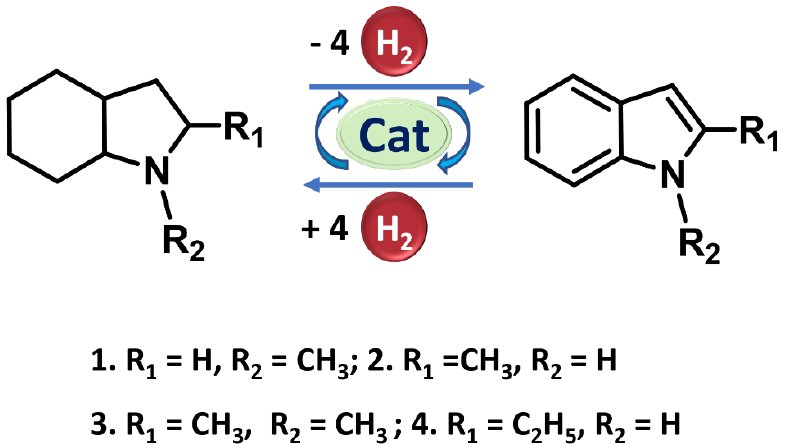
Figure 7. Schematic illustration of the LOHC system using perhydro-indole derivatives/indole derivatives.